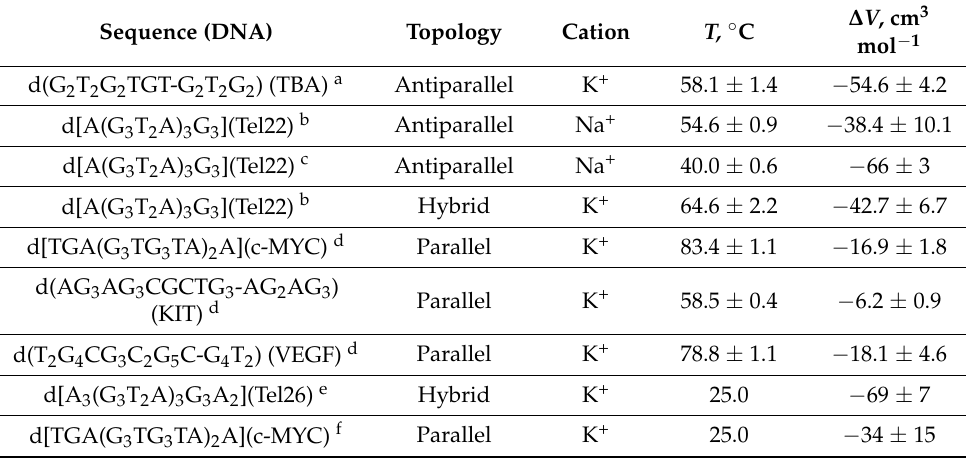
Table 1. Changes in volume, ∆ V , accompanying the unfolding transitions of G-quadruplexes differing in sequence, topology, and stabilizing cation determined at temperature, T . Sequence (DNA) Topology Cation